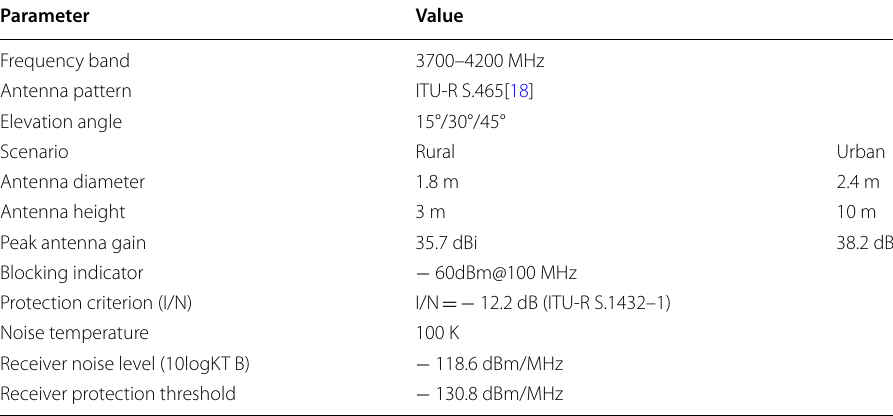
Table 4 Fixed satellite service